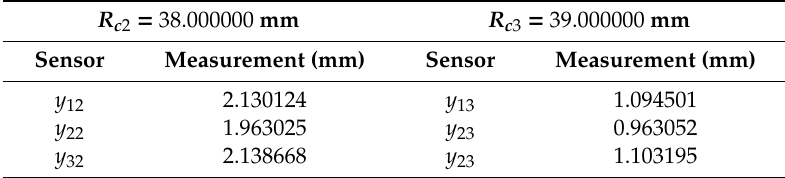
TPIK algorithm based on CAD simulation studied for several initial